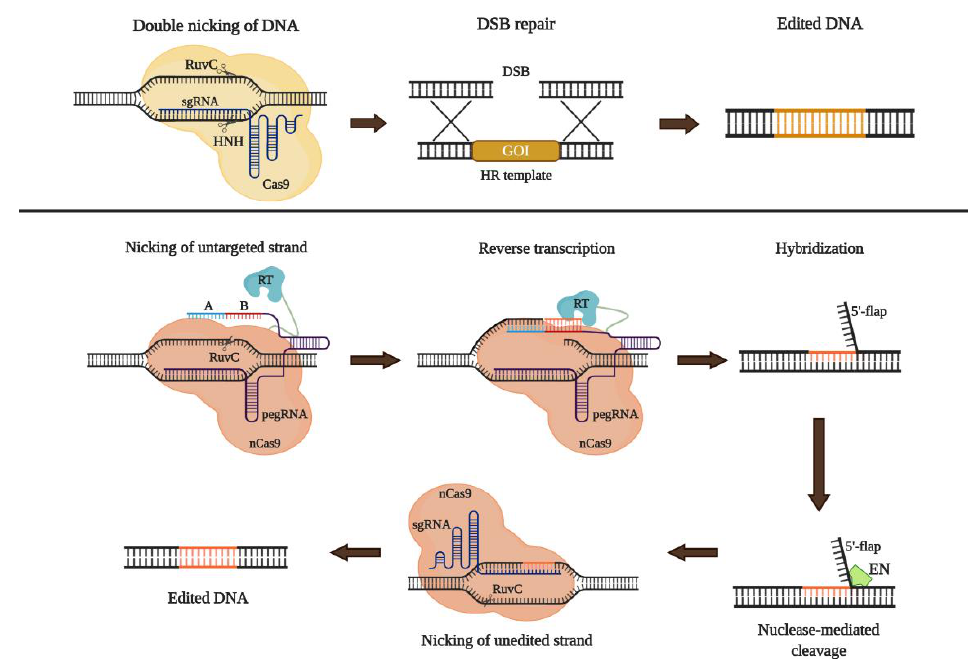
Figure 6. Approaches for genome editing using CRISPR/Cas9. The upper panel shows the classical strategy of knock-in using a ribonucleoprotein complex (sgRNA-guide Cas9) to guide to Cas9 to the target DNA and cut the double-strand (DSB). After the DSB, repair machinery is activated. In the presence of a donor sequence (HR template), homologous recombination is favored. To promote the recombination event of a gene of interest (GOI), the HR template must be flanked by homologous recombination arms which are complementary to the 5′ and 3′-ends of the sequence into the gene that will be subject of edition. Typically, between 100-150bp and 400-800bp are suitable for small (<50 bp) and large (>100) insertions, respectively [165,166]. In the lower panel, Prime Editing (PE) is represented. PE uses a nickase Cas9 (nCas9-H840A) fused to reverse transcriptase (RT) and a guide RNA (pegRNA) which is engineered with a sequence in the 5′-end.20 nucleotides guide to nCas9 to the target DNA and a sequence in the 3-end with a primer-binding site (A) as well as an RT template (B) that could be between 7 to 12 nucleotides [167]. Upon reverse transcription, newly synthesized strand hybridizes to the unedited strand (US) forming a mismatch and a 5′-flap strand which is removed by exonucleases (EN) such as EXO1 [168]. The mismatch is resolved with the introduction of a new nCas9 coupled to a simple sgRNA which guide to nCas9 to the edited strand (ES), about 50 bp from the pegRNA-mediated nick, to cut the US and use the sequence of the ES as a template for repair de simple cut [167]. In both cases upper and lower panels, newly edited DNA is successfully obtained with different efficiencies.